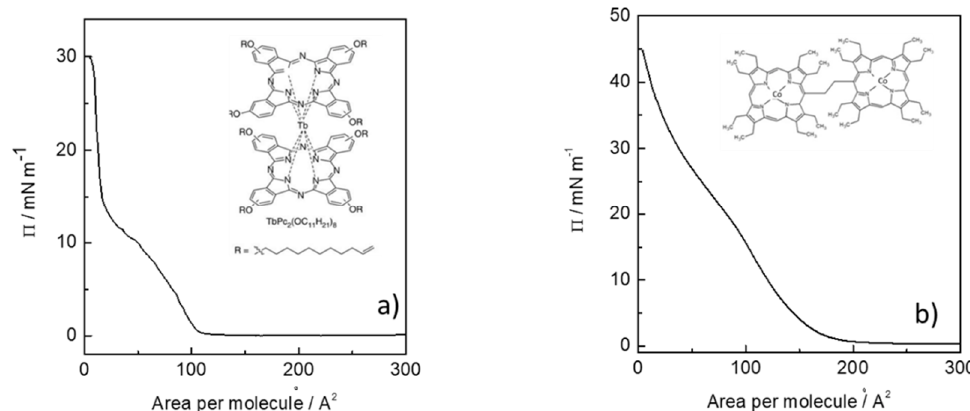
Figure 2. Π -area per molecule isotherm curves for the floating film of TbPc 2 (OC 11 H 21 ) 8 (panel a ) and CoCoPo 2 (panel b ).